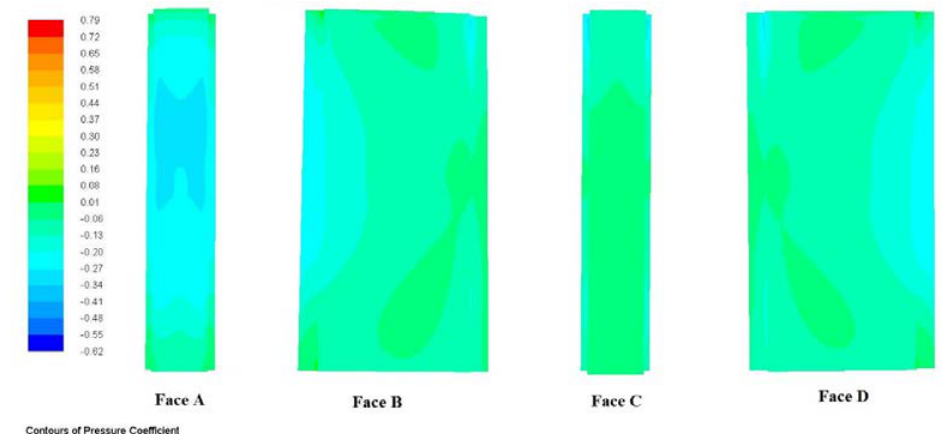
Fig. 5(a). Contours of pressure coefficient at 0° Wind incidence angle.